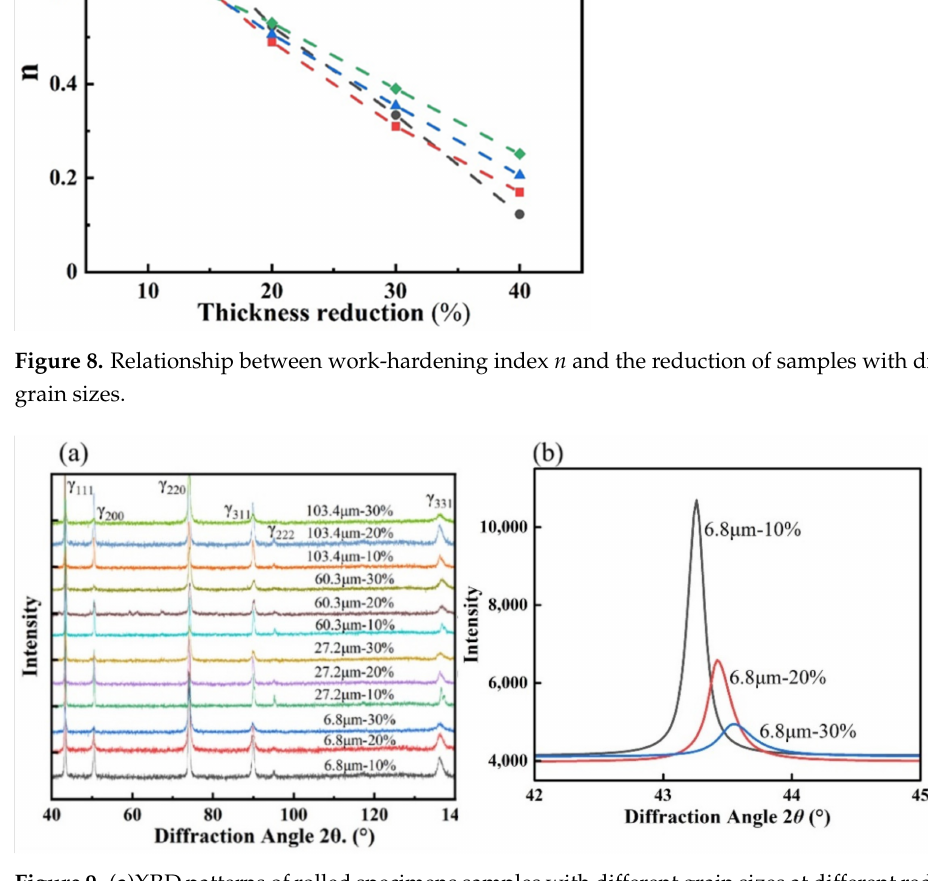
Figure 9. ( a )XRD patterns of rolled specimens samples with different grain sizes at different reduction; ( b ) The (111) diffraction peaks of samples with the average grain size of 6.8 µ